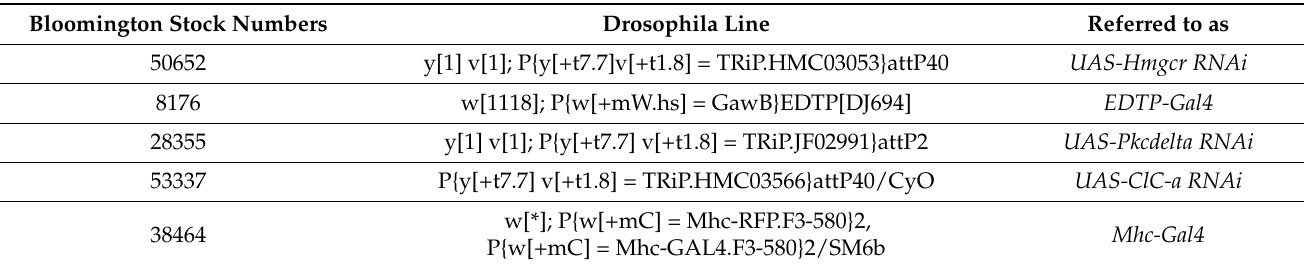
Table 1. Fly stock purchased from the Bloomington Stock Center and used in this